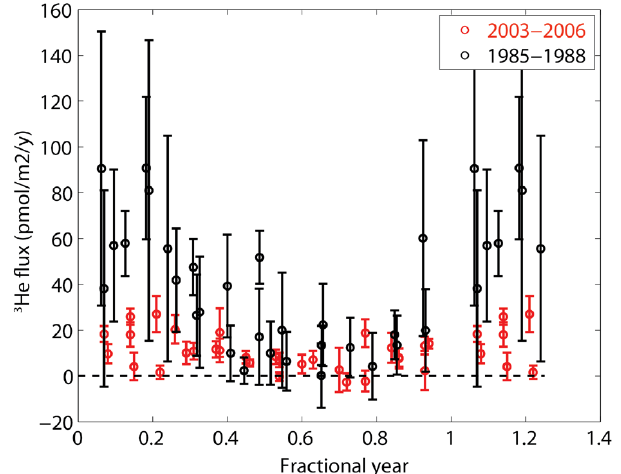
Figure 5. The 3 He flux as a function of fractional year for the 2003– 2006 time period (red) and the 1985–1988 time period (black). The time period between 0 and 0.4 has been replicated from 1 to 1.4 in order to better visualize a seasonal